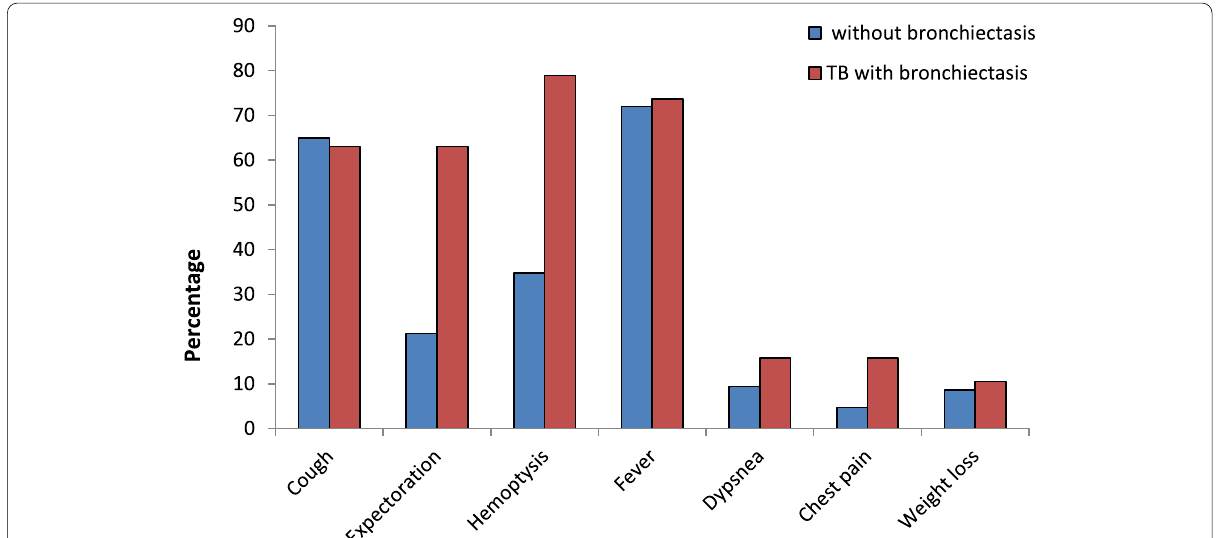
Fig. 2 Clinical presentation among enrolled TB patients based on the presence of bronchiectasis ( N